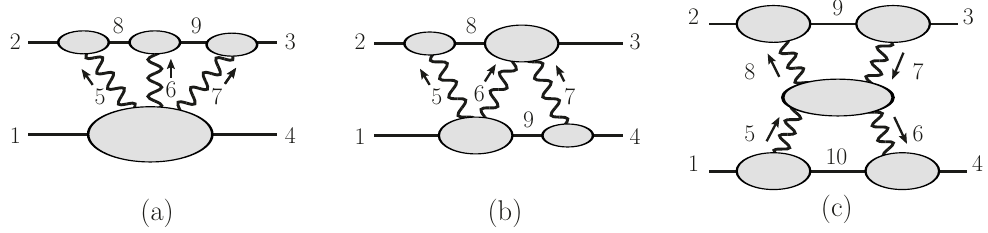
Figure 12 . The independent generalized cuts needed at two loops for the classical potential. The remaining contributing cuts are given by simple relabeling of external legs. Here the straight lines represent on-shell scalars and the wiggly lines correspond to on-shell gravitons or gluons. Using (cid:28) 15 + (cid:28) 45 = t on the cut, we can organize the above equation into standard cut (cid:0) integrals. As before, the cut in (cid:12)gure 7(b) may be obtained by a simple relabeling.